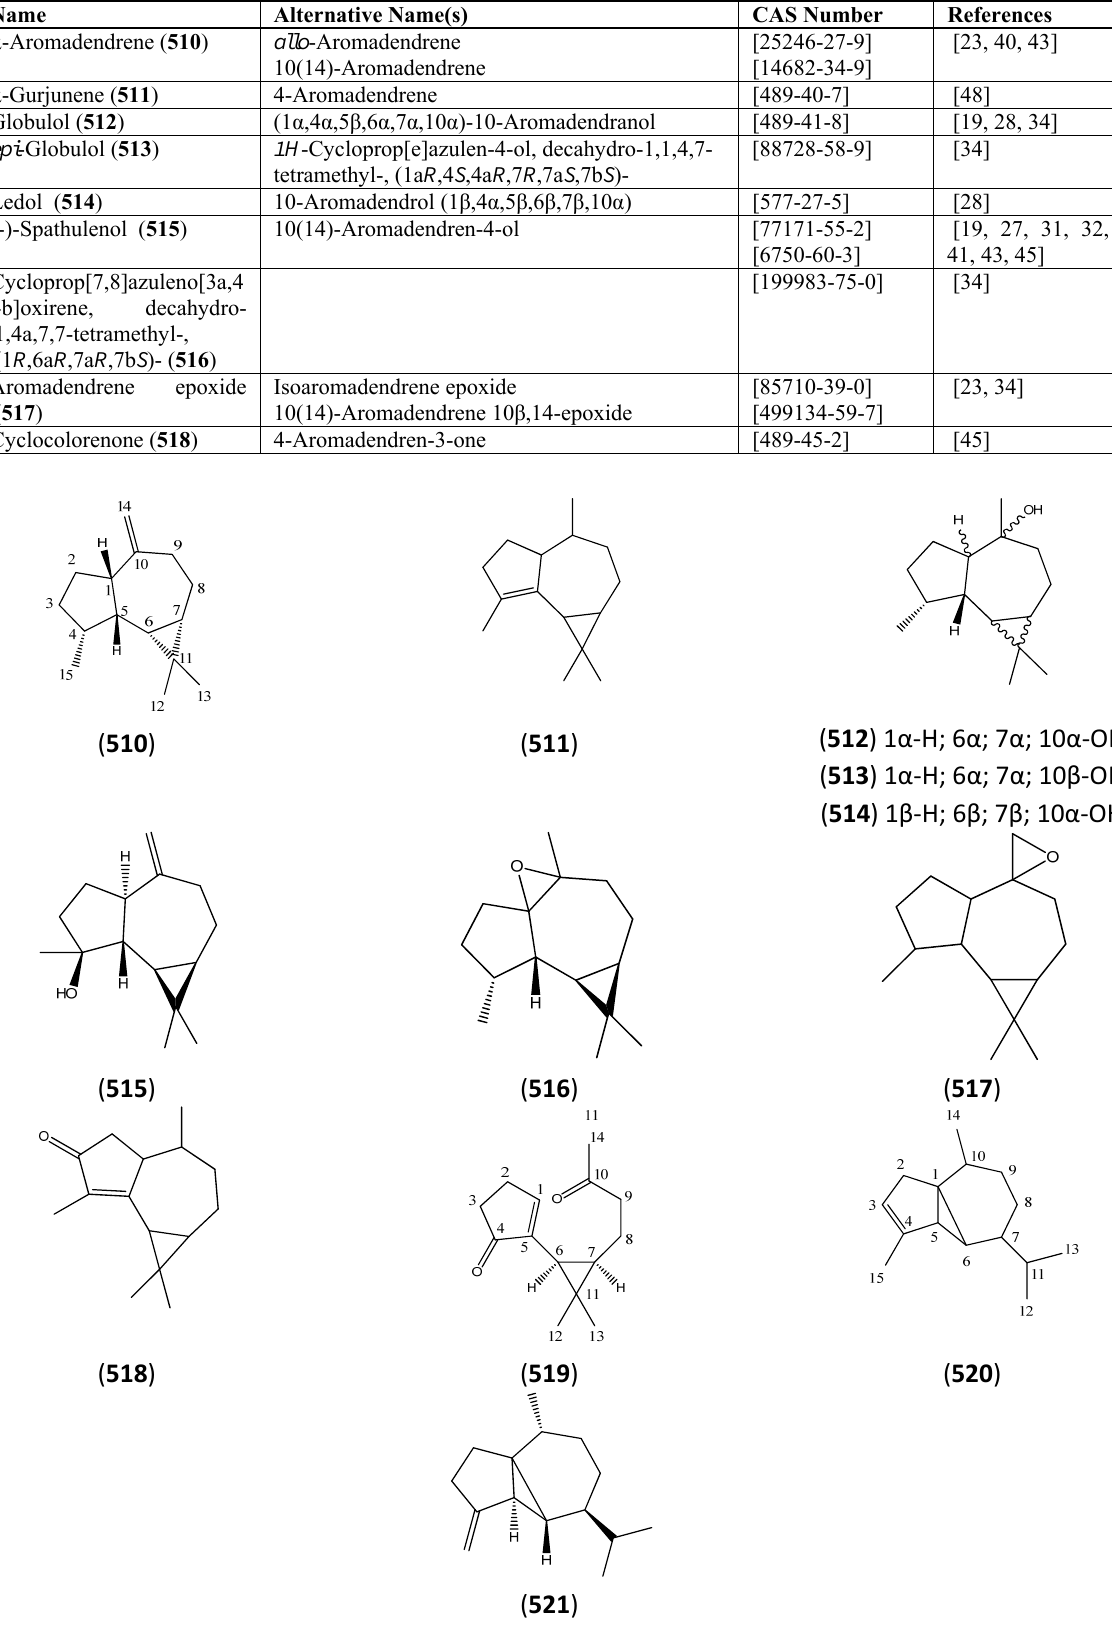
Table 40. Aromadendrane Sesquiterpenoids (Decahydro-1,1,4,7-tetramethyl- 1H - cycloprop[e]azulene.